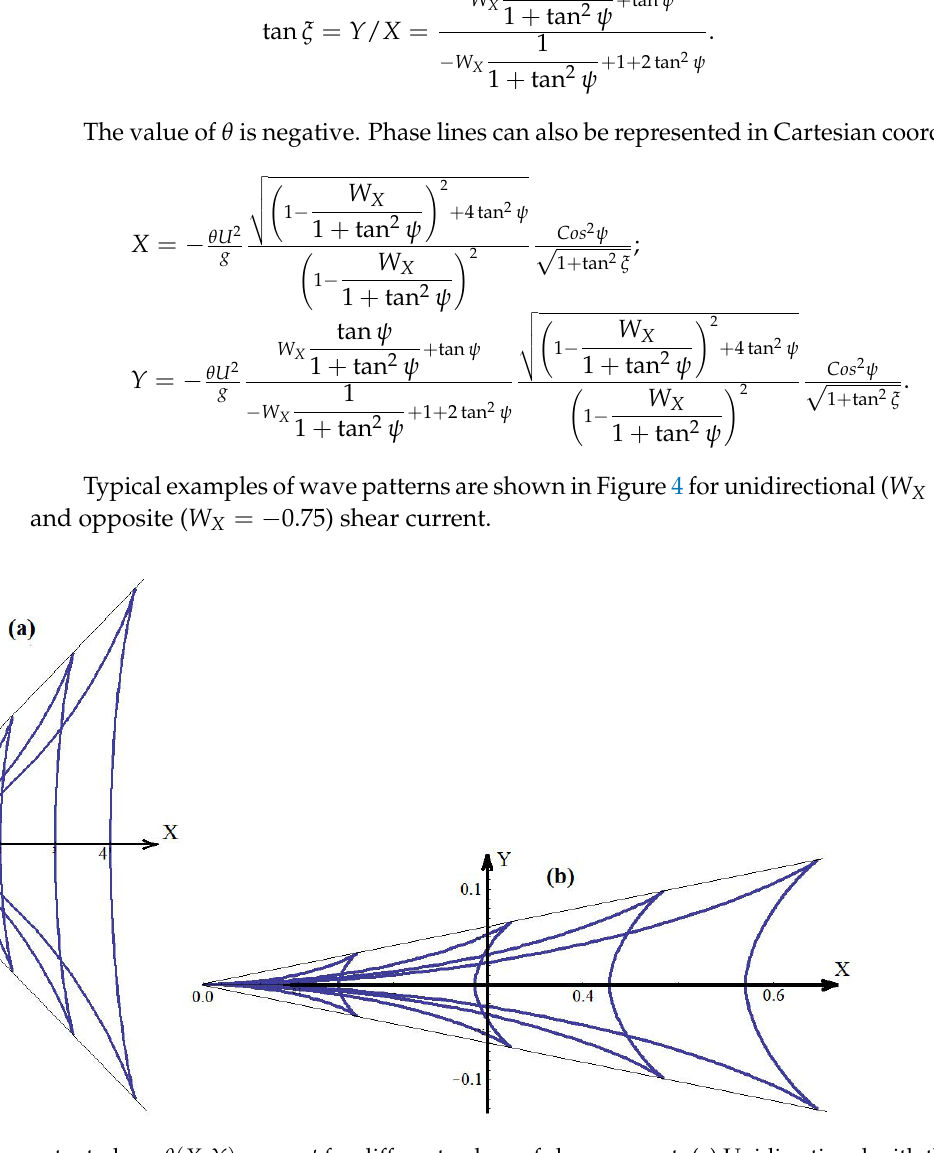
Figure 4. The lines of the constant phase θ ( X , Y ) = const for different values of shear current: ( a ) Unidirectional with the ship ( W X = 0.75) shear current; ( b ) Opposite ( W X = − 0.75) shear